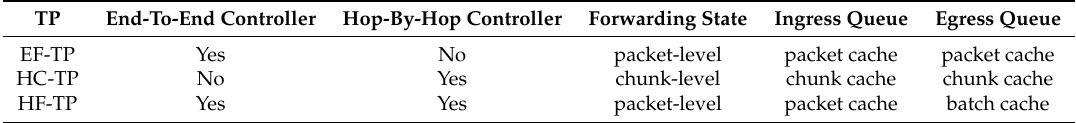
Table 2. Architectural design comparison among TPs.